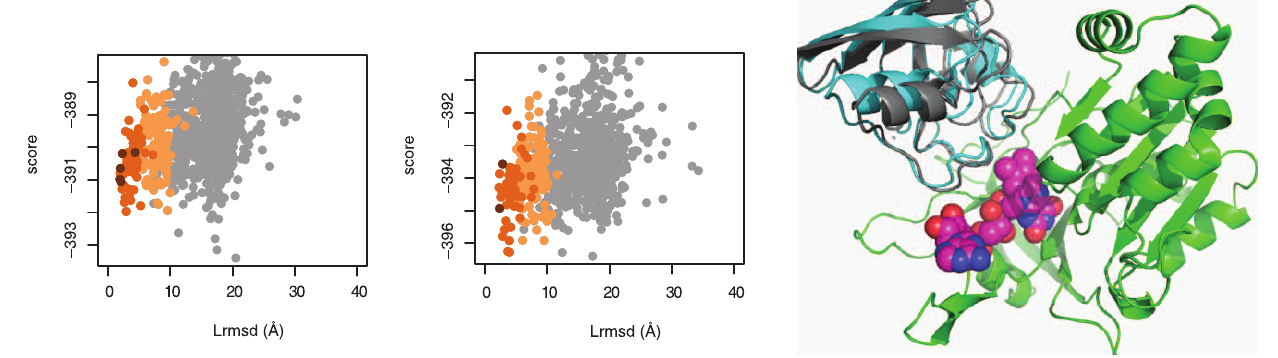
Figure 6. Docking of the FNR-Fn ternary complex. Plots of score vs. Lrmsd for local docking of the unbound structures in target 1EWY without (A) and with (B) the small molecule FAD bound to FNR (A), with high, medium, and acceptable accuracy decoys colored in brown, orange, and tan, respectively. (C) The second-lowest energy structure from docking using FAD with FNR (green), Fd (cyan), and the FAD molecule (magenta) superimposed on the crystal structure of the complex